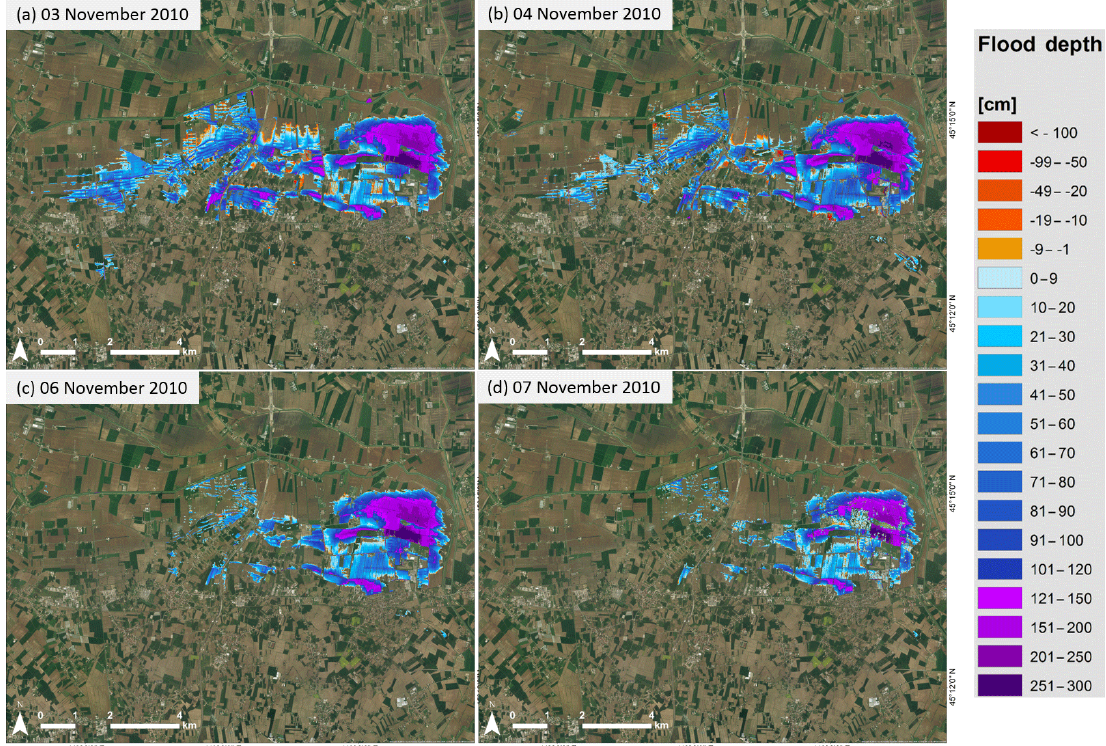
Figure 8. Flood depth for the area of interest of Saletto on (a) 3, (b) 4, (c) 6, and (d) 7